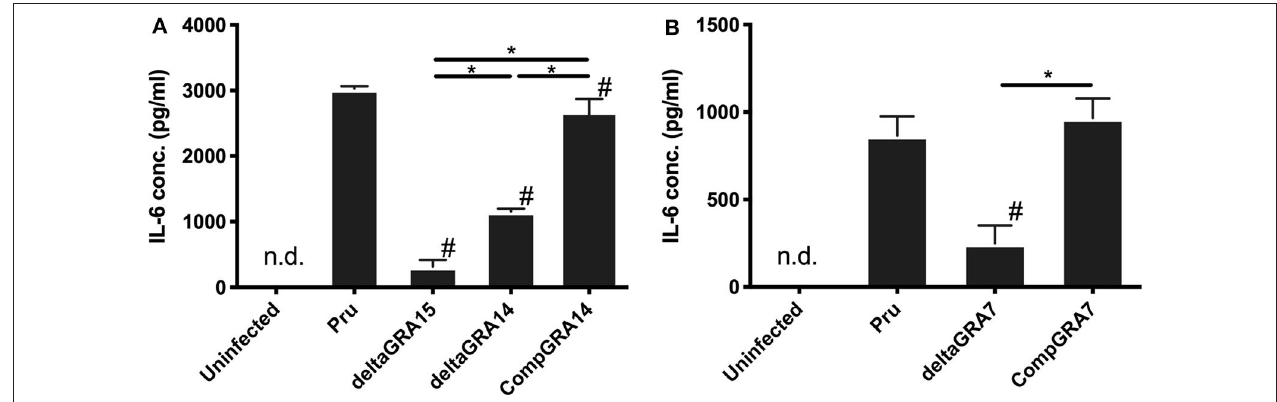
FIGURE 5 | Levels of interleukin-6 in Raw246.7 macrophage cells. (A) Raw246.7 macrophage cells were infected with the parental Pru, Pru 1 gra15 , Pru 1 gra14 , and GRA14 complemented parasite strains. (B) Raw246.7 macrophage cells were infected with the parental Pru, Pru 1 gra7 , and GRA7 complemented parasite strains. (A,B) At 24h post-infection, supernatants were collected and IL-6 levels were determined by cytokine ELISA. These experiments were performed three times using triplicate samples. Values are the means ± SD of triplicate samples, * indicates a significant difference (* p < 0.05). #a significantly lower level of IL-6 compared with the Pru strain infected cells ( p < 0.05). Differences were tested by one-way ANOVA with turkey’s post-hoc test. Experiments for Pru 1 gra14 and the complemented lines were performed in tandem with Pru 1 gra15 , and experiments for Pru 1 gra7 and the complemented lines were performed